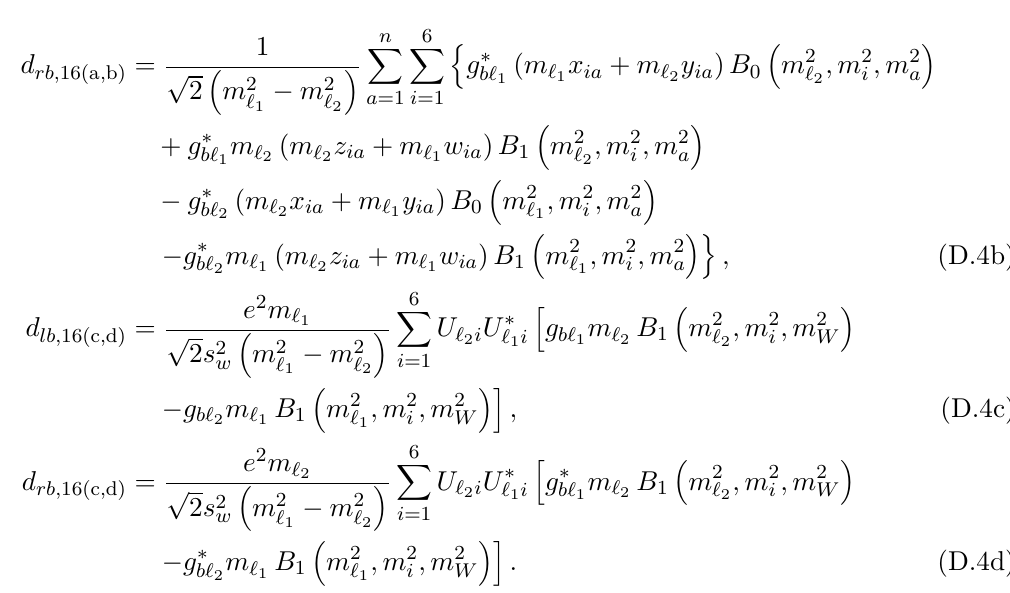
Figure 17 . Diagram for S 0 d rb, 16(a , b)